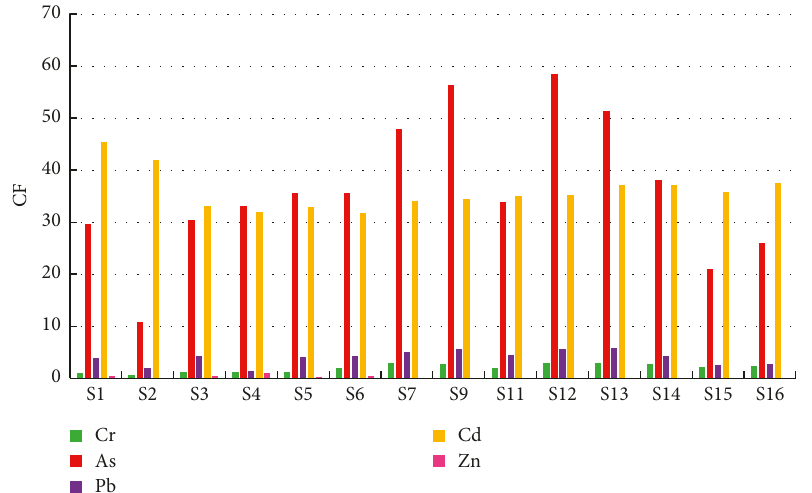
Figure 3: The column chart of the concentration factor (CF) of heavy metals in sediments.